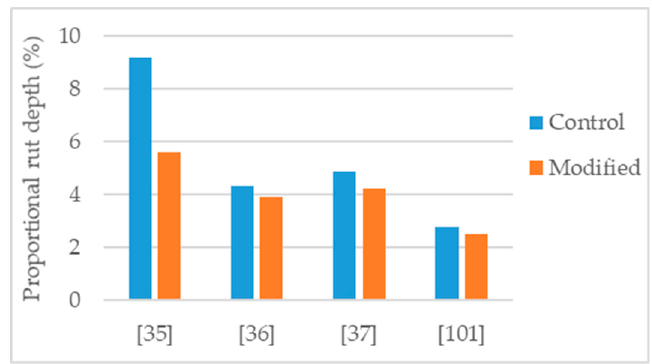
Figure 11. Proportional rut depth of control and nanoclay modified asphalt mixtures.